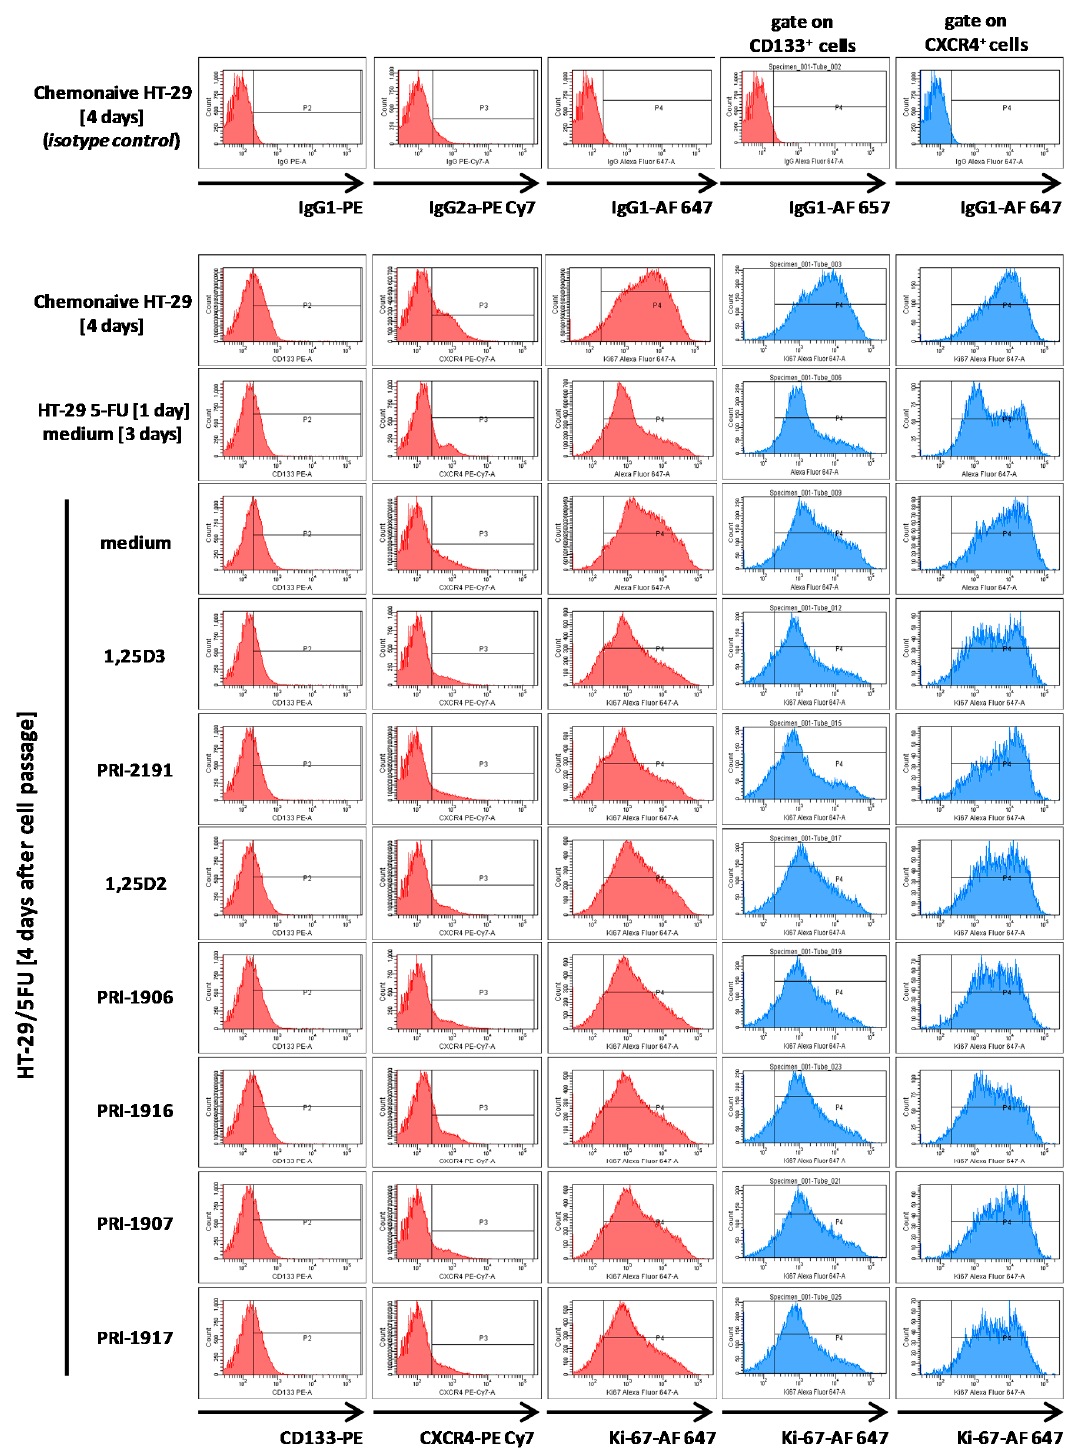
Figure 4. Flow cytometry analysis of CD133, CXCR4 and Ki-67 expression in chemonaive HT-29 cells, HT-29/5-FU cells on the third day after 5-FU removal from the culture, and in HT-29/5-FU cells passaged and cultured for four days with or without vitamin D analogues. CD133 and CXCR4 expression is shown for total chemonaive HT-29 cells and total HT-29/5-FU cell population. Ki-67 expression was analyzed in total cell populations and in gates set for CD133 + cells or CXCR4 + cells. Data from one out of three experiments with similar results are shown. Histograms showing analysis of samples labeled with fluorochrome-conjugated unspecific antibodies of respective isotypes, used as a negative control, are shown in the top row. Abbreviations: IgG—immunoglobulin G, AF 647—Alexa Fluor 647.